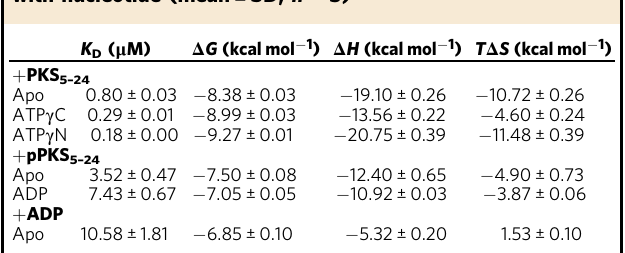
Table 1 The af fi nity, enthalpy, entropy and free energy of substrate (PKS 5 – 24 ), phosphorylated substrate (pPKS 5 – 24 ), and nucleotide (ADP) binding to PKA-C without (Apo) or with nucleotide (mean ± SD, n = 3)